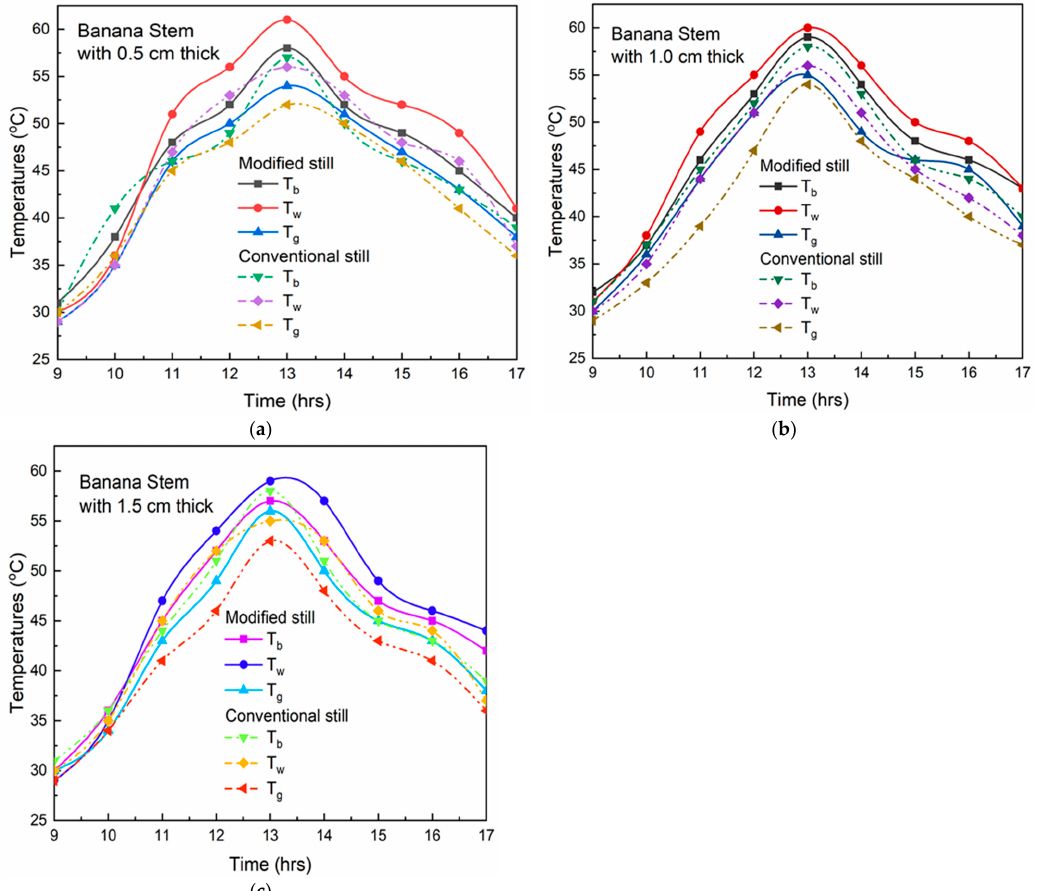
banana stems, respectively. The maximum hourly water purification production effi- ciency of 83% was attained for the 0.5 cm-thick banana stems in the MSS in contrast to the CSS. The conventional still produced 685 mL, 670 mL, and 680 mL of distillate on three different days, but the modified still produced 934 mL, 865 mL, and 780 mL of distillate with the 0.5 cm-, 1.0 cm-, and 1.5 cm-thick banana stems, respectively. The banana stem with a 0.5 cm thickness produced yields of 36.35%, 7.97%, and 19.74% more in contrast to the CSS for the studies of 1.0 cm and 1.5 cm thickness. Figure 4. Variation in temperature for the ( a ) 0.5 cm-, ( b ) 1.0 cm-, and ( c ) 1.5 cm-thick banana stems. With three different thicknesses of banana stems, the hourly yield and cumulative yield of both the CSS and MSS have been graphically depicted in Figures 5 and 6, respec- tively. It is shown from the graphs that the distillate yield generated was more for the 0.5 cm-thick banana stems in contrast to the 1.0 cm- and 1.5 cm-thick banana stems. This is due to the capillary action of the banana stems. As the banana stem thickness increases, the time required for water vapor to reach the evaporation surface also increases. Another reason is that only a layer of water is available on the banana stem surface which rapidly evaporated as the camphor soothing of the banana stem readily absorbs energy from the sun. The maximum hourly water production was achieved at mid-day and those values were 0.88 kg m − 2 h − 1 , 0.88 kg m − 2 h − 1 , and 0.84 kg m − 2 h − 1 for the MSS and 0.48 kg m − 2 h − 1 ,